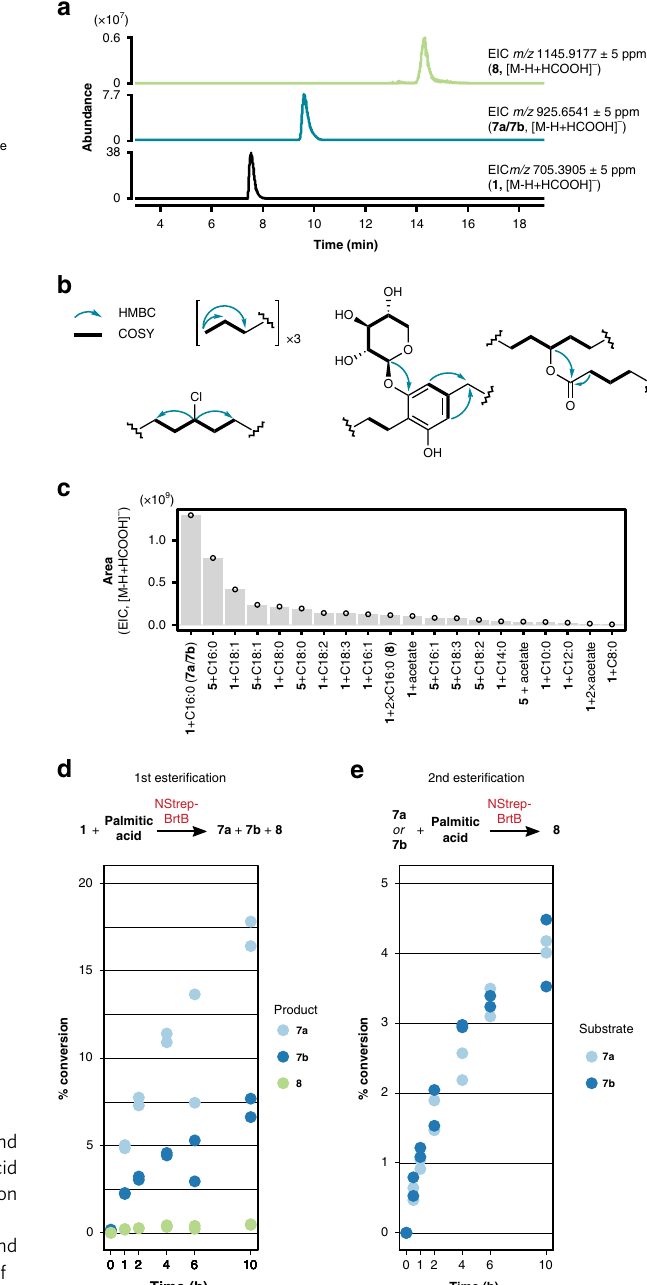
Fig. 4 Fatty acid-bartoloside esters are natural products. a LC-HRESIMS analysis of an organic extract of S. salina LEGE 06099 suggests the presence of bartoloside A ( 1 )-palmitic acid esters. b Key HMBC and COSY correlations obtained from 1D and 2D NMR analysis of bartoloside A palmitate 7a puri fi ed from S. salina LEGE 06099 cells. c Bartoloside esters found in cells from a 30-day old culture of S. salina LEGE 06099 (as con fi rmed by HRESIMS/MS analysis) and their relative abundance, determined by LC-HRESIMS ( n = 1). d , e Selectivity of the BrtB-catalyzed esteri fi cations leading to bartoloside A palmitates. Shown are LC- HRESIMS analysis-derived conversions (from EIC peak areas and assuming similar ionization behavior) in assays quenched at different time points for the fi rst esteri fi cation ( d n = 2 independent assays) showing that 7a is the preferred product and for the second esteri fi cation ( e n = 2 independent assays) indicating that both 7a and 7b are converted into 8 at comparable